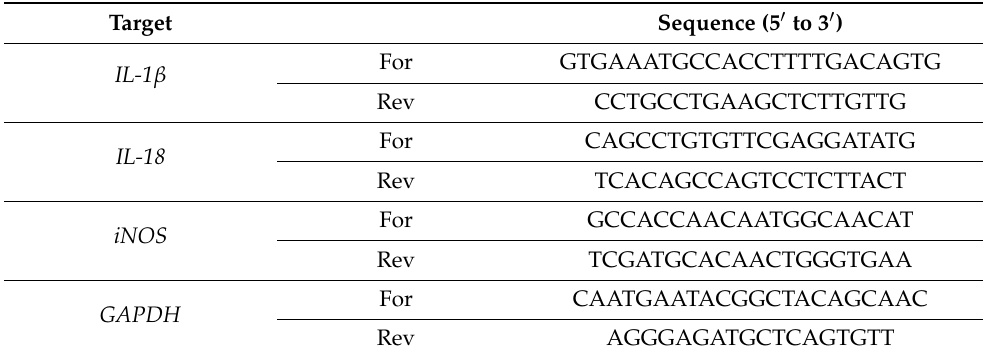
Table 2. Primer sequences used for